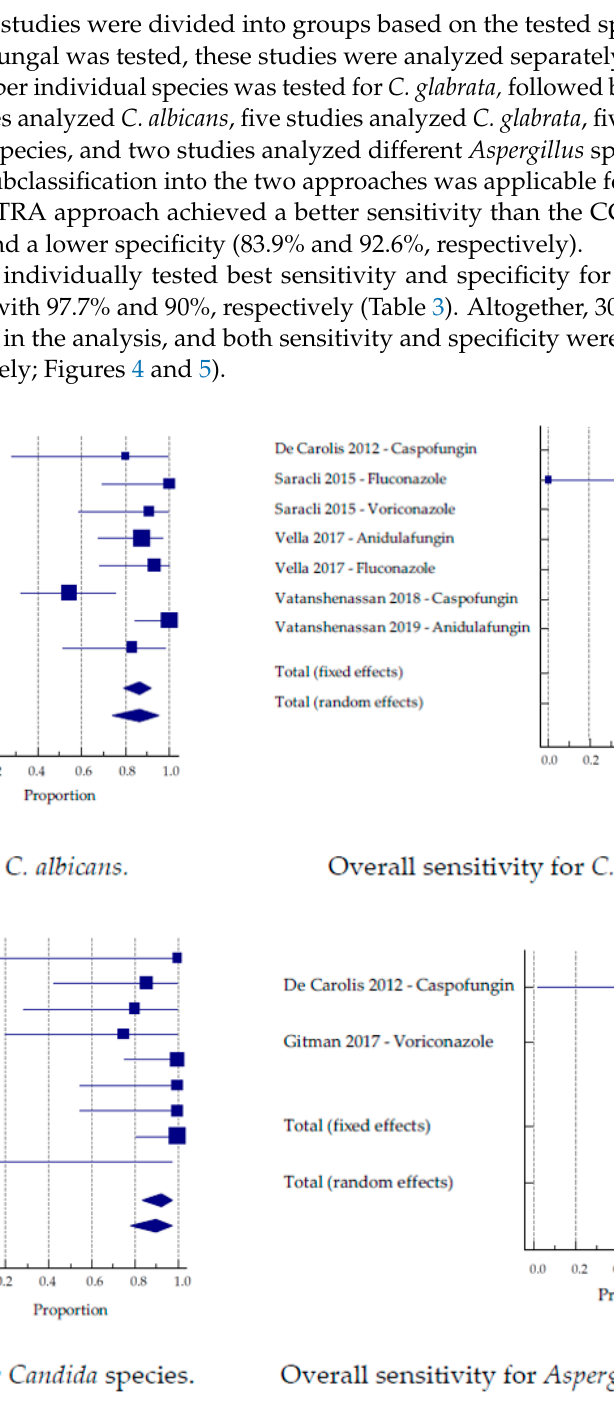
Figure 4. Sensitivity by the group of the antifungal substance.